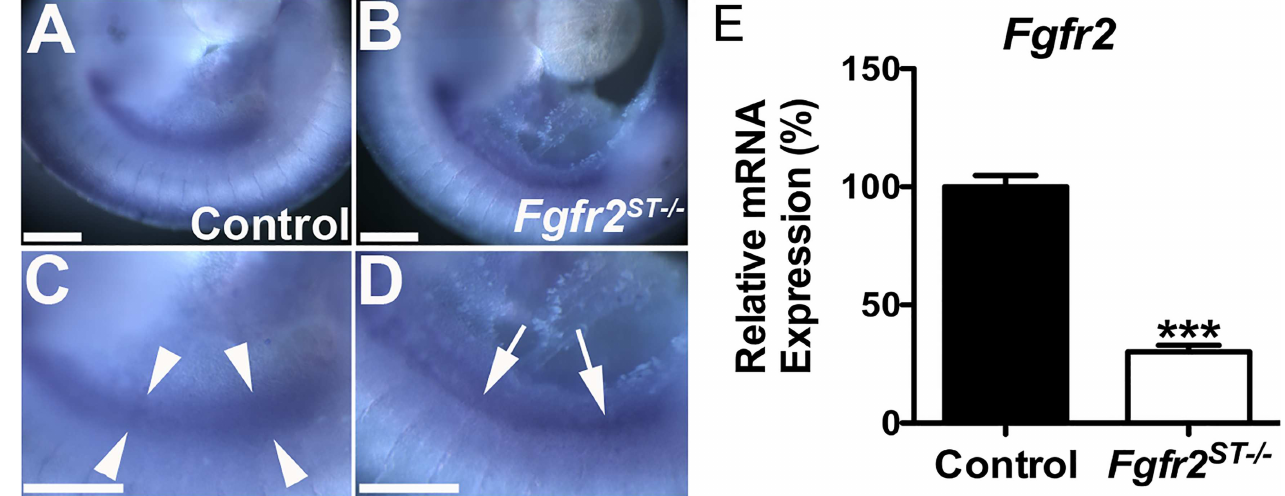
Fig 2. Expression of Fgfr2 in E10.5 in control and Fgfr2 ST − / − embryos. A,C. Lower power (A) and higherpower (C) images show that control embryos have a wide band of Fgfr2 signal(between arrowheads) encompassing the Wolffian duct and surrounding stroma. B,D. Lower power (B) and higherpower (D) images show that Fgfr2 ST − / − embryos have a linear band of Fgfr2 expressionin the Wolffian duct epithelium(arrows) and not in the surroundingstroma. E. Quantitative real-time PCR of FAC-sorted E10.5 Cag-Tbx18cre Tg/+ (Control) and Cag-Fgfr2 ST − / − ( Fgfr2 St − / − ) urogenitalridges confirms a dramatic decreasein Fgfr2 mRNA expressionin mutant Tbx18cre expressingcells. Scale bars = 100 μ m. *** p < 0.001 vs. control embryos.